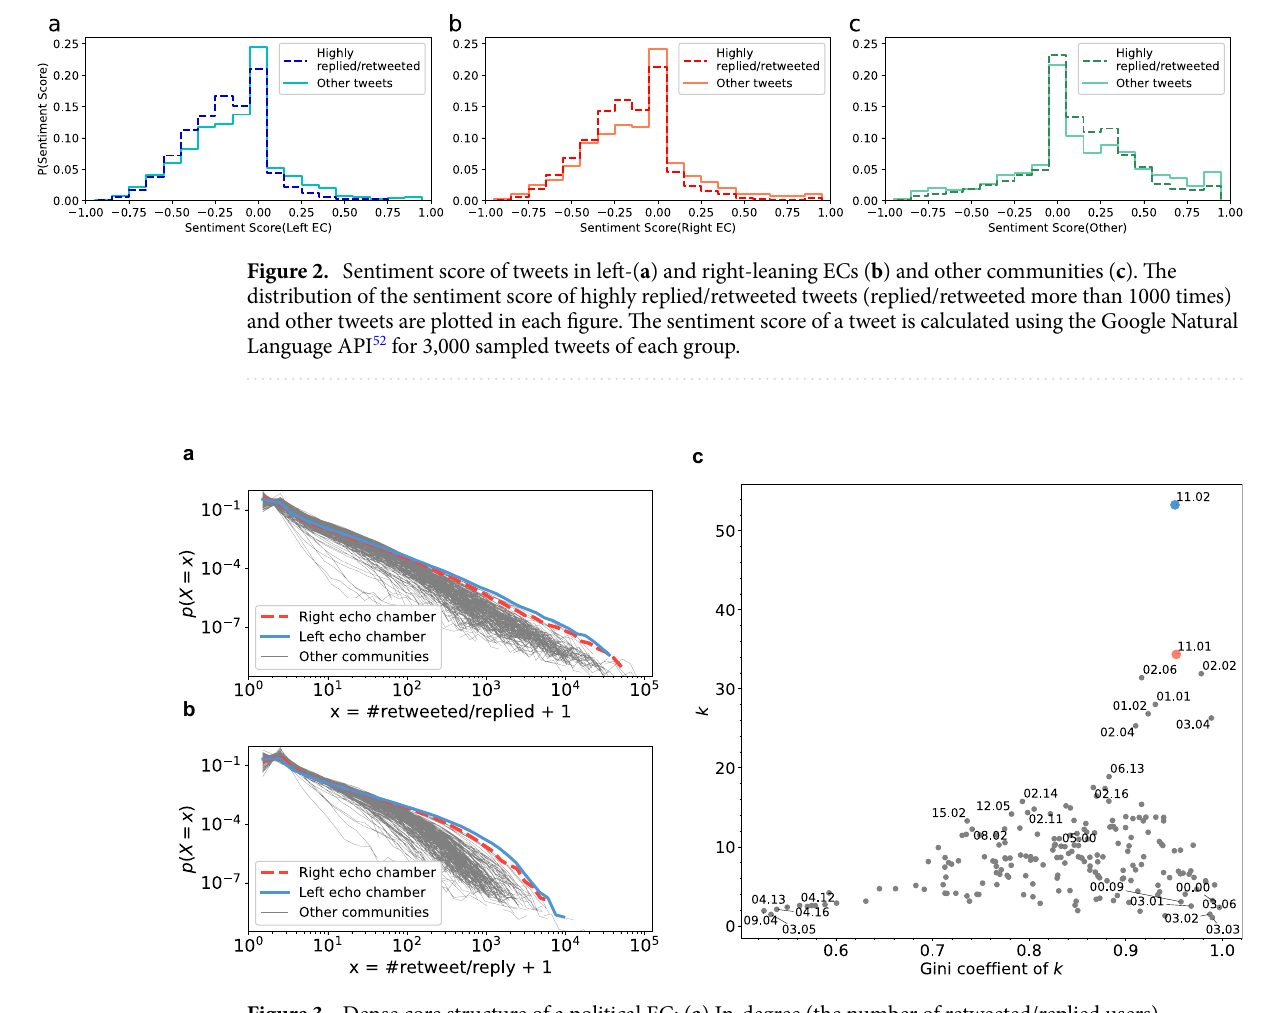
Figure 3. Dense core structure of a political EC: ( a ) In-degree (the number of retweeted/replied users) distribution of the left and right ECs with other communities. ( b ) Out-degree (the number of reply/retweet users) distribution of the left and right ECs with other communities. ( c ) Scatter plot of each community. The horizontal axis indicates the Gini indicator of degree distributions and the vertical axis indicates the average number of